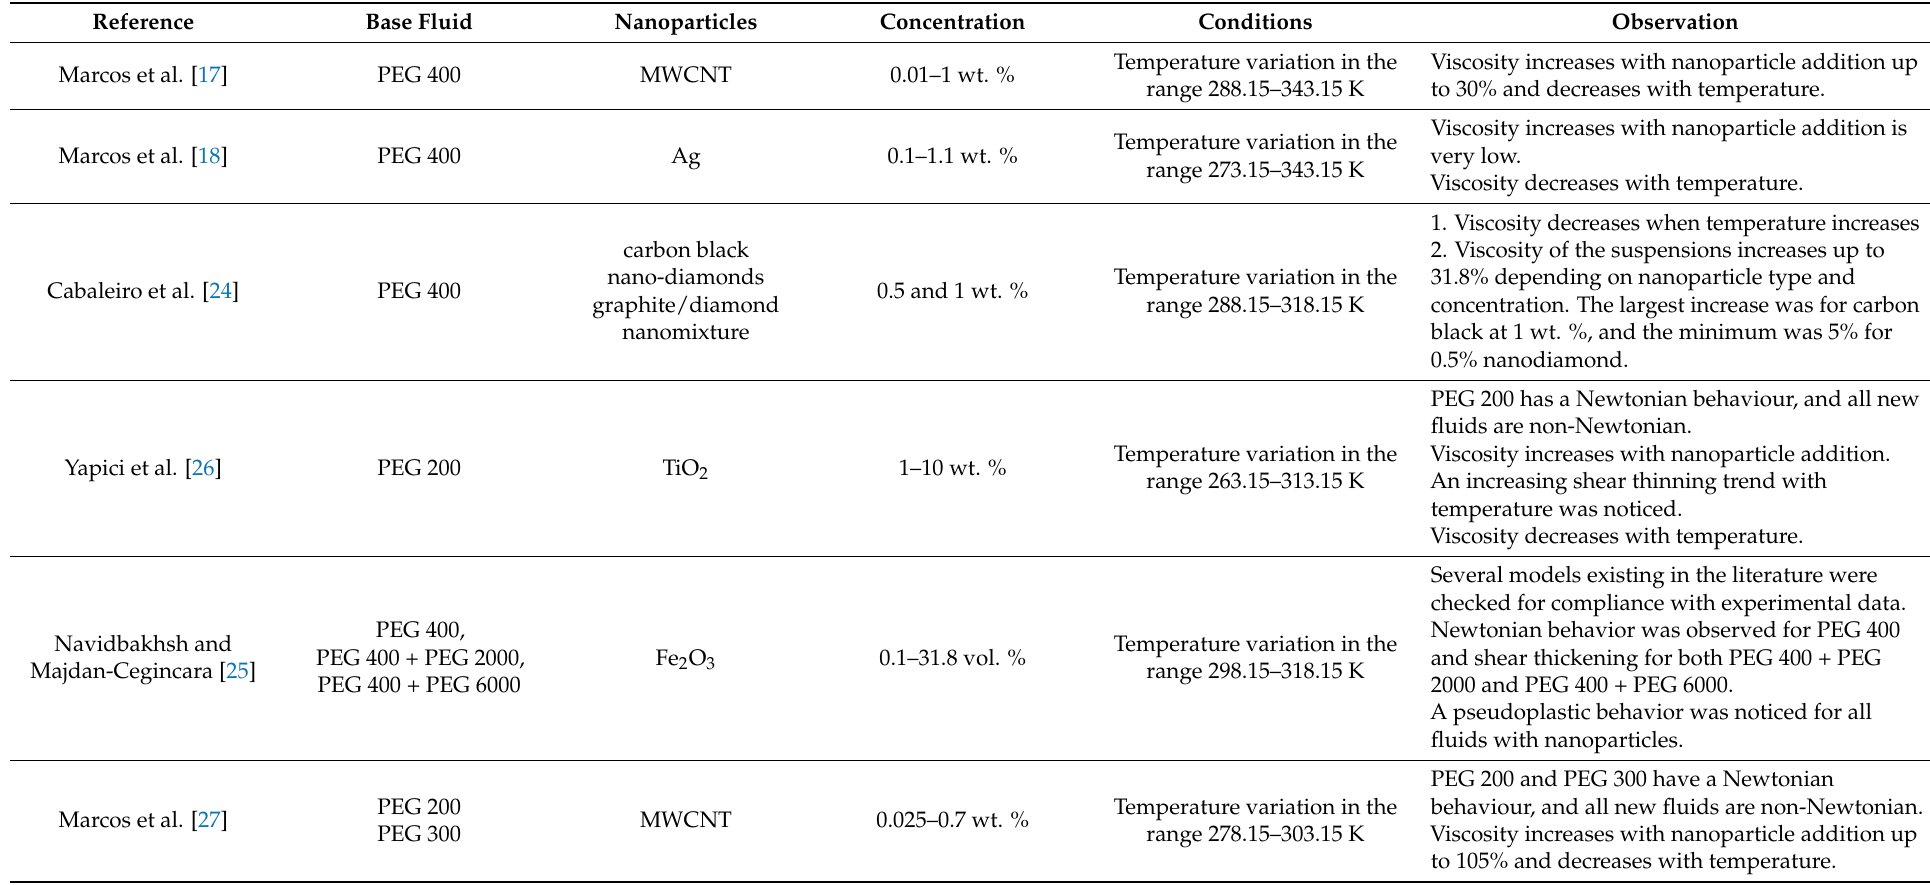
Table 5. Results for